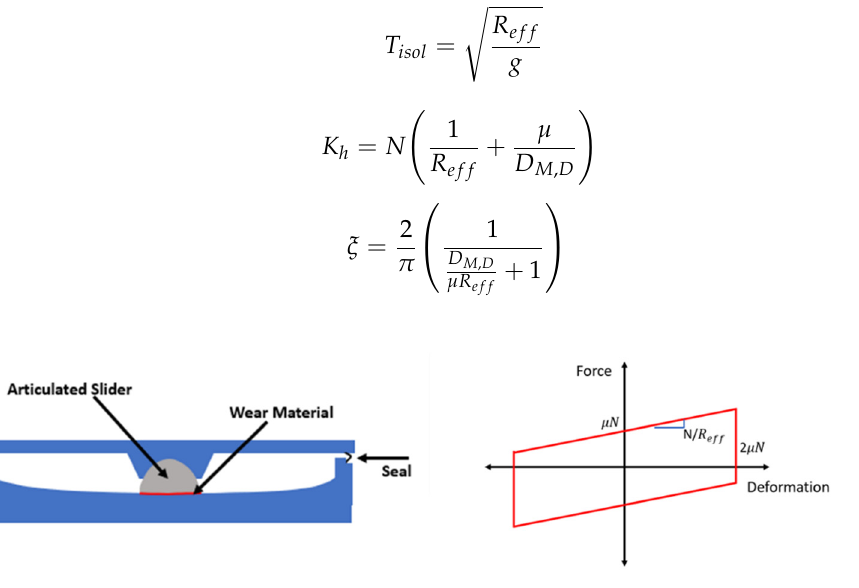
Figure 9. Conventional curved surface friction slider with single sliding interface.